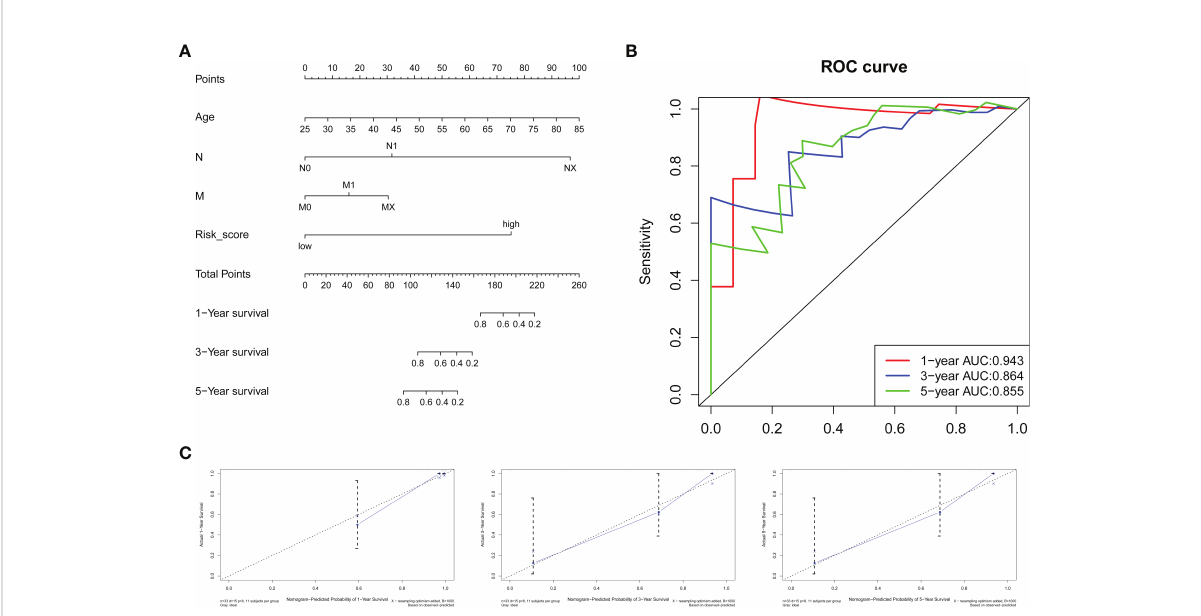
FIGURE 8 Nomogram for survival prediction. (A) A nomogram was built by combining the RS and clinical characteristics. (B) AUCs of ROC curves for 1-, 3-, and 5- year survival predictions were used to estimate the predictive accuracy of the nomogram. (C) Calibration plots predicting the 1-, 3- and 5-year survival probabilities of CCA patients. The predicted survival probability is displayed on the x-axis, and the actual survival probability is presented on the